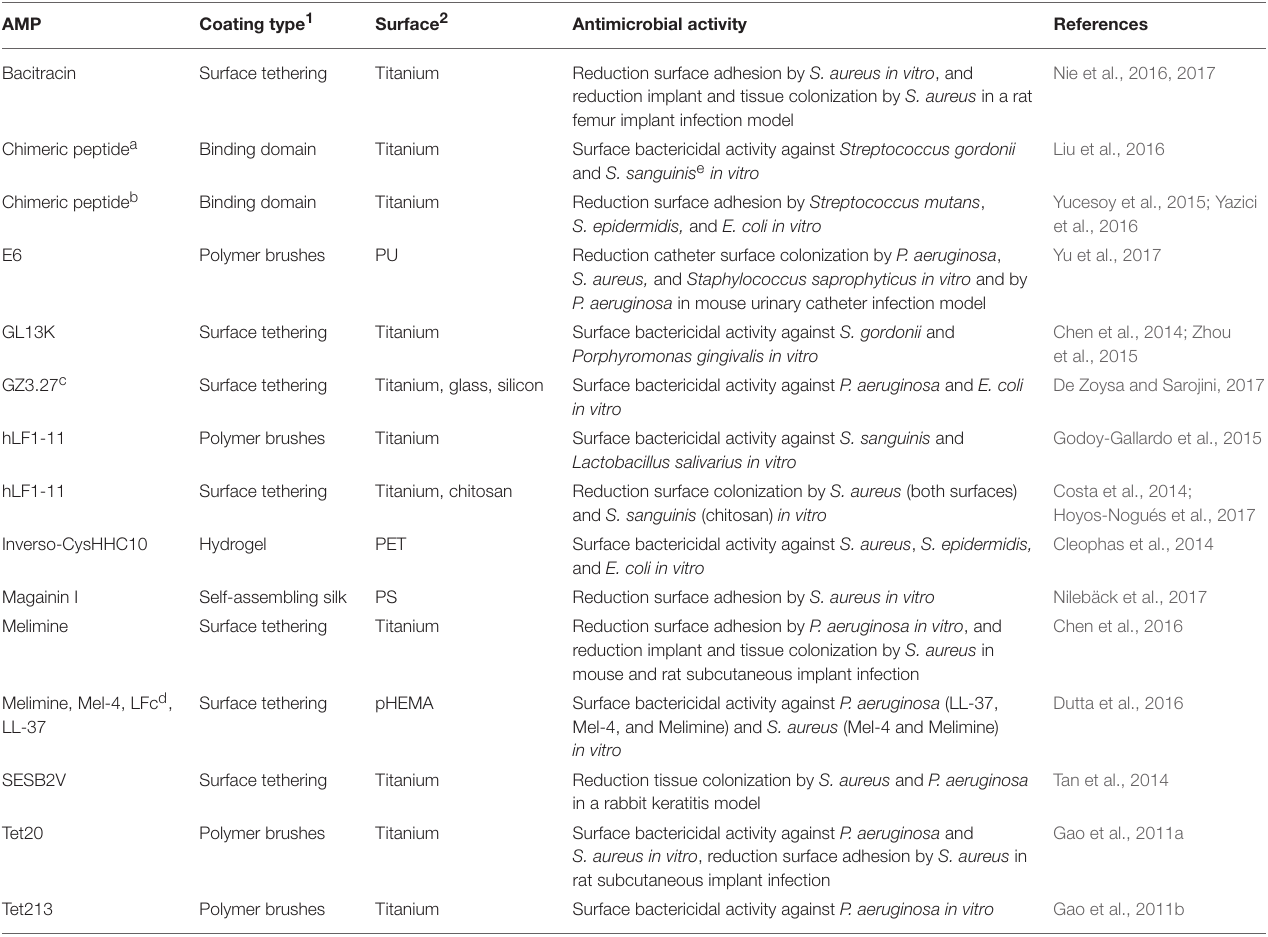
TABLE 1 | Overview AMP contact-killing